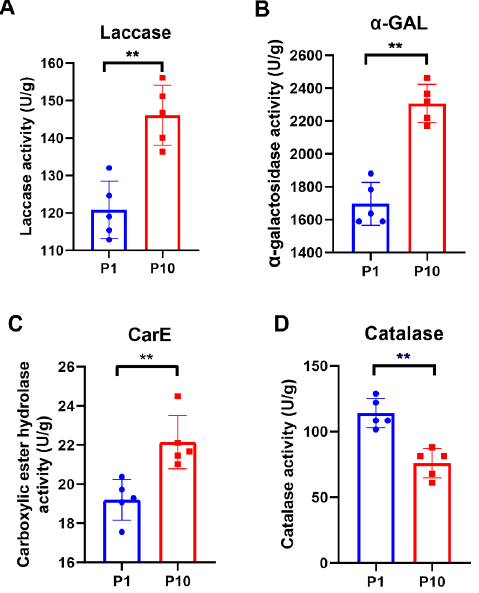
Figure 5. Enzymatic assay of the representative metabolic enzymes in P1 and P10. Each assay included five biological replicate and all the statistical analyses were performed with GraphPad Prism 8 software, using a non-parametric Mann–Whitney test (** p -value ≤ 0.0079). Table 1. Quantitative expression of the metabolic enzymes in the DEPs.